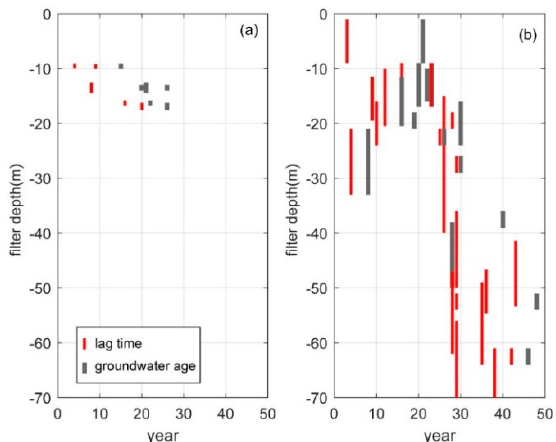
Figure 7. Groundwater ages (chlorofluorocarbon (CFC) measurements) and lag times (CCF statistical estimates) of groundwater in ( a ) Tunø and ( b ) Aalborg-Drastrup. The intervals of the intake filters are on the y -axis.